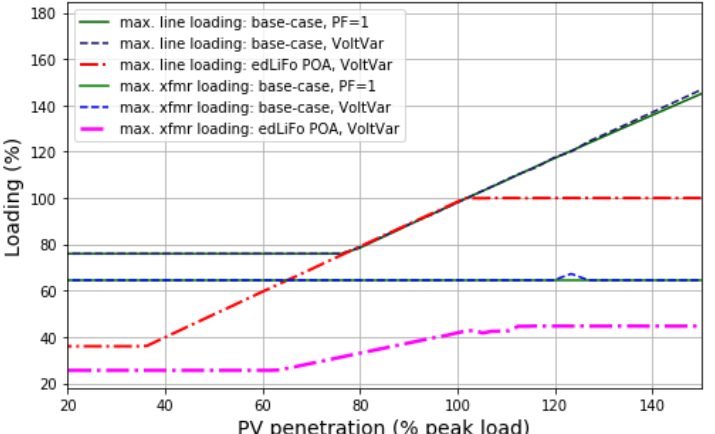
Figure 10. Line and transformer thermal loading per PV penetration by study case.